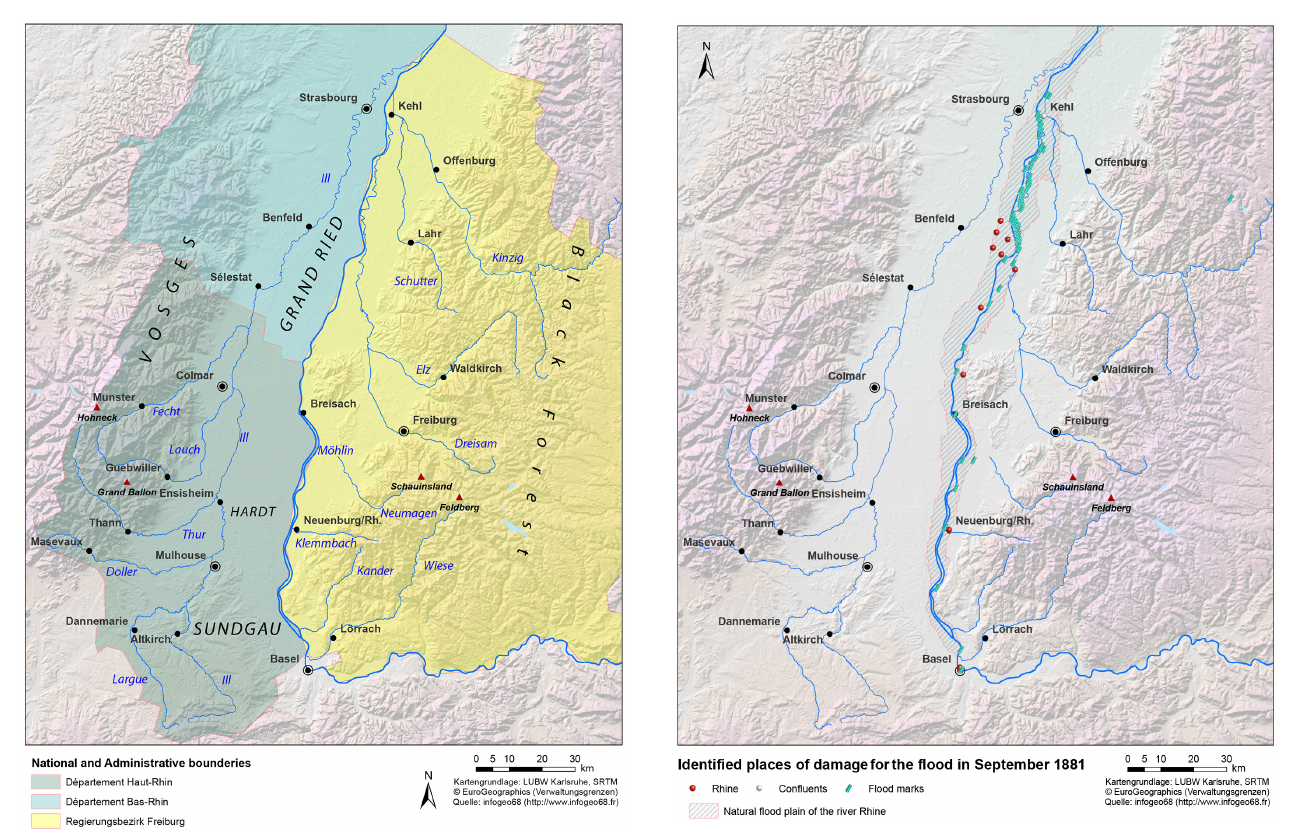
Figure 1. Study area including the researched rivers and actual ad- ministrative districts in France and Germany.